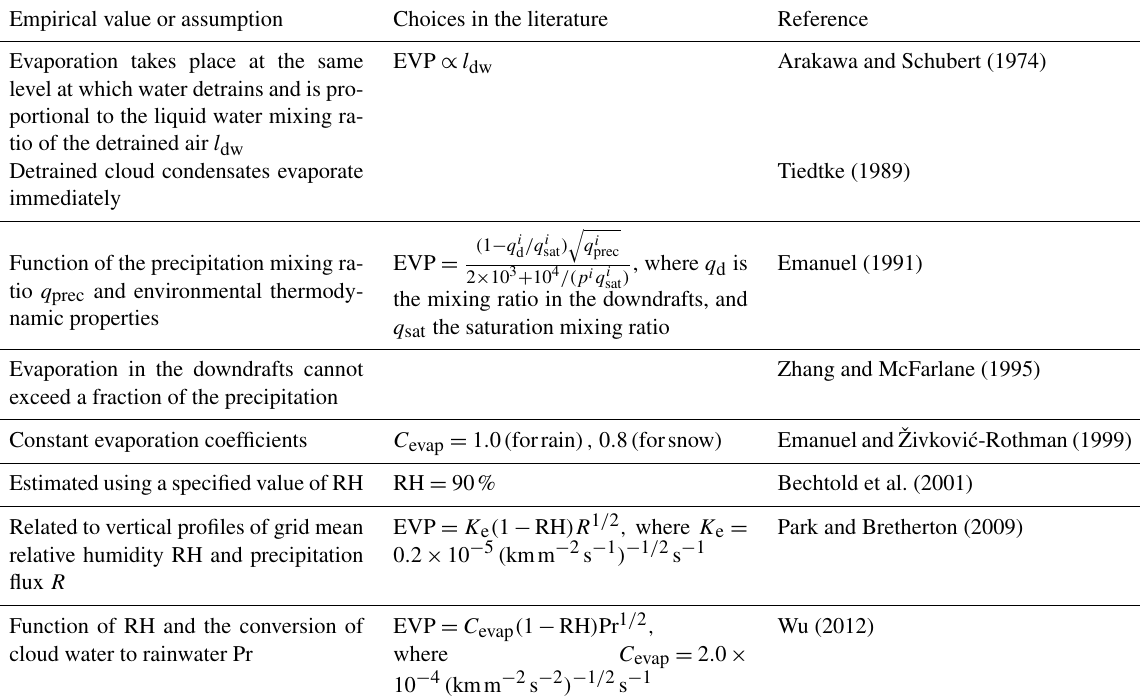
Table 11. A sample of empirical values and assumptions used in the evaporation in the downdraft. Empirical value or assumption Choices in the literature